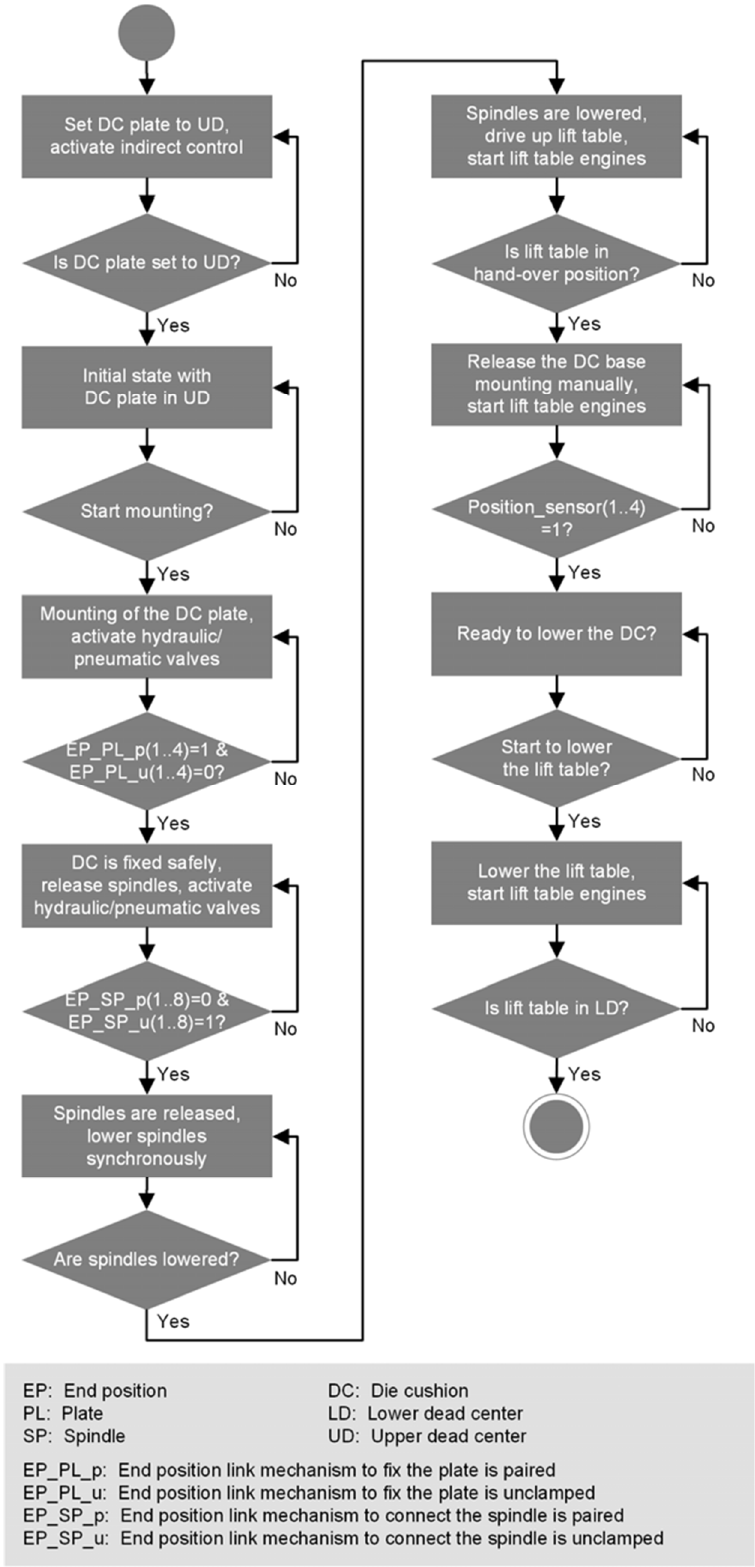
Figure 2. Sequence plan for the commissioning process of the die cushion with the related machine data.